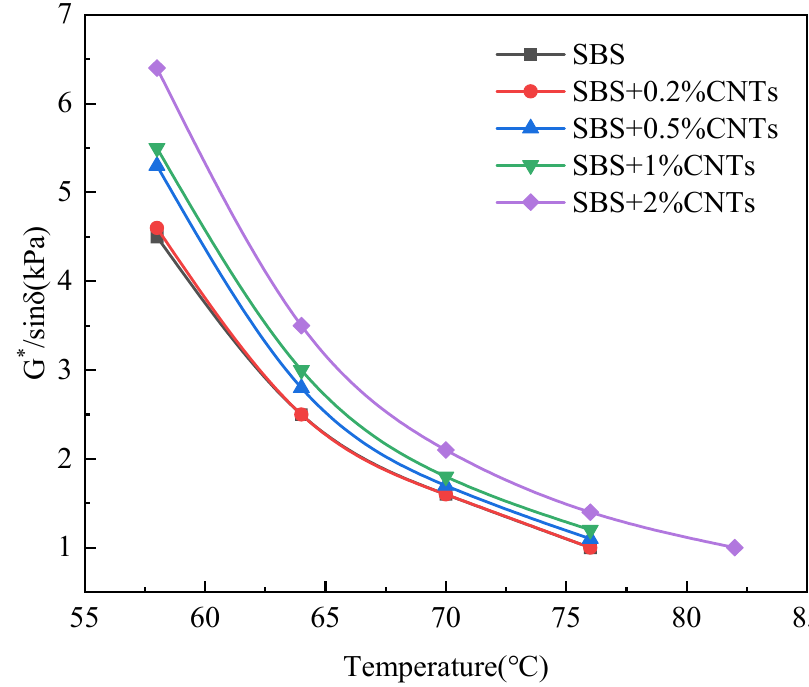
Figure 1. Relationship between G*/sinδ and temperature of unaged asphalt binder.